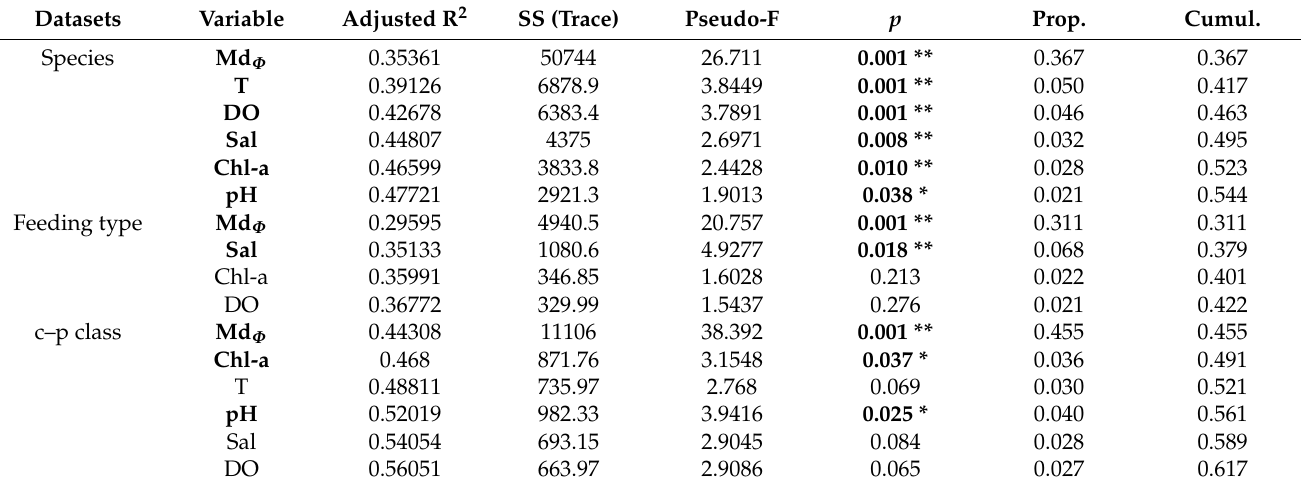
Table 4. Results of the DistLM sequential test for nematode datasets. SS, sum of square; F, F statistic; Prop, the proportion of the variability explained; T, sea water temperature; Sal, sea water salinity; DO, sea water dissolved oxygen; Chl-a, Chlorophyll-a; TOM, total organic matter; Md Φ , median particle diameter. **, p < 0.01; *, p < 0.05. Statistically significant correlations are indicated in